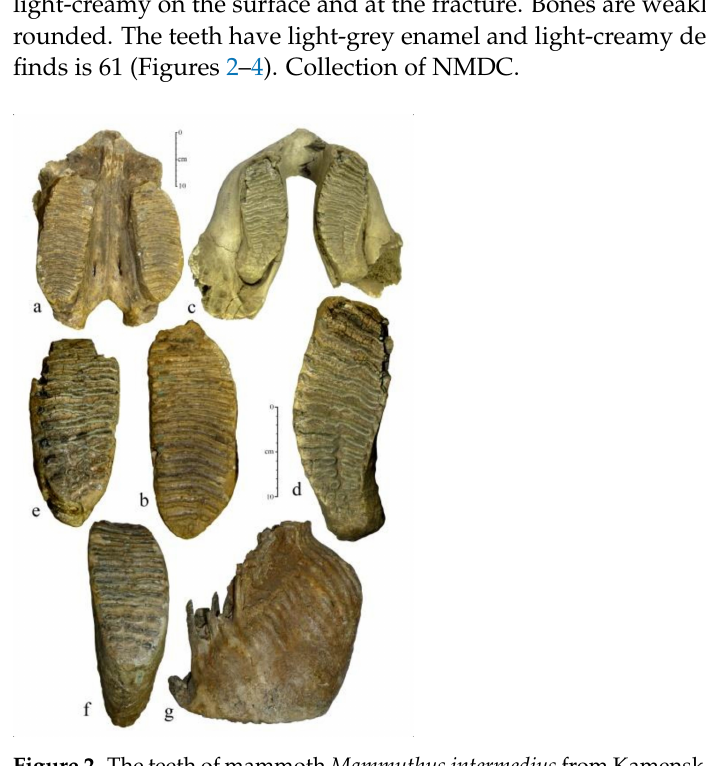
Figure 2. The teeth of mammoth Mammuthus intermedius from Kamensk-Shakhtinskiy (Rostov Region, Russia), the late Middle Pleistocene: ( a )—NMDC No. Pal-59, fragment of skull with M3s, ventral view, ( b )—NMDC No. Pal-59, left M3, occlusal surface, ( c )—NMDC No. Pal-85, lower jaw, dorsal view, ( d )—NMDC No. Pal-85, right m3, occlusal surface, ( e )—NMDC No. Pal-91, right M3, occlusal surface and ( f , g )—NMDC No. Pal-19 left M3, occlusal surface, buccal